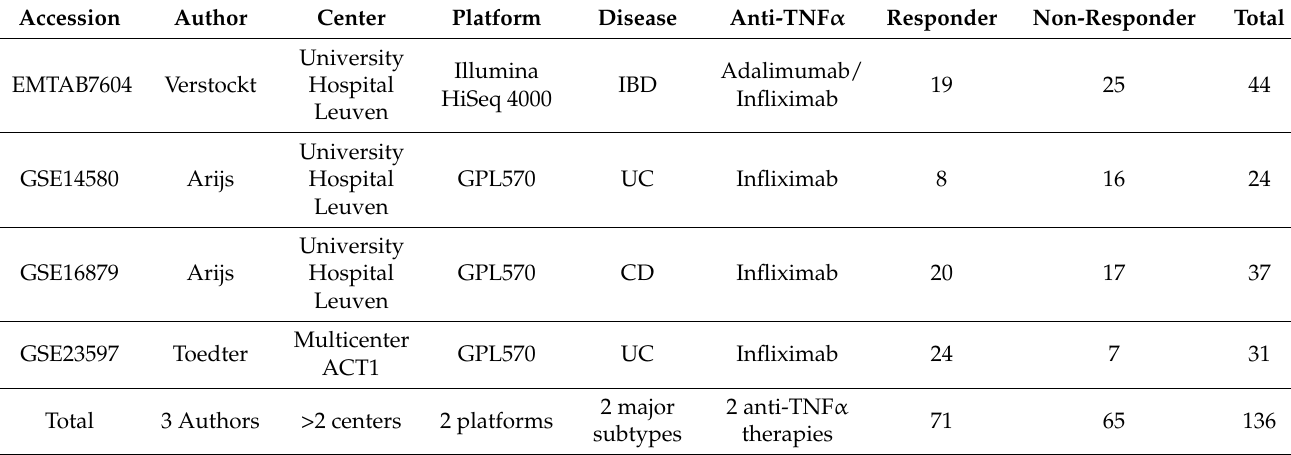
Table 1. Mucosal biopsy datasets used for multicohort analysis. Responders and non-responders were labeled based on cohort’s annotation criteria, as described in